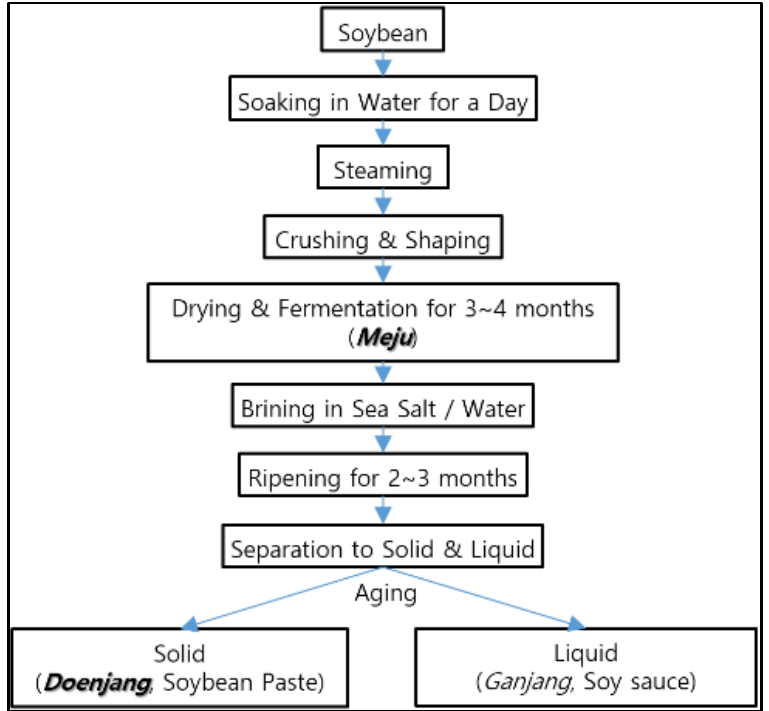
Figure 1. The general manufacturing flow of traditional Doenjang.